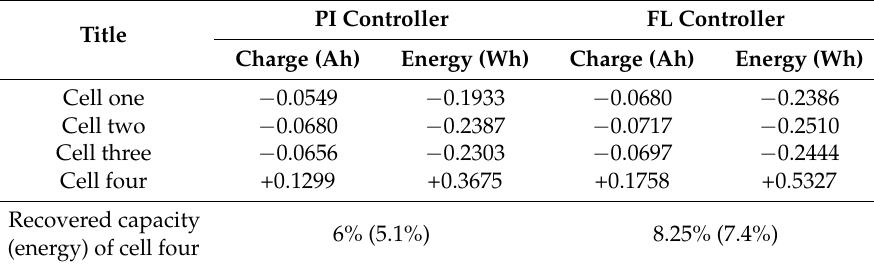
Table 3. Balancing Results for the LiFePO 4 Battery Pack.